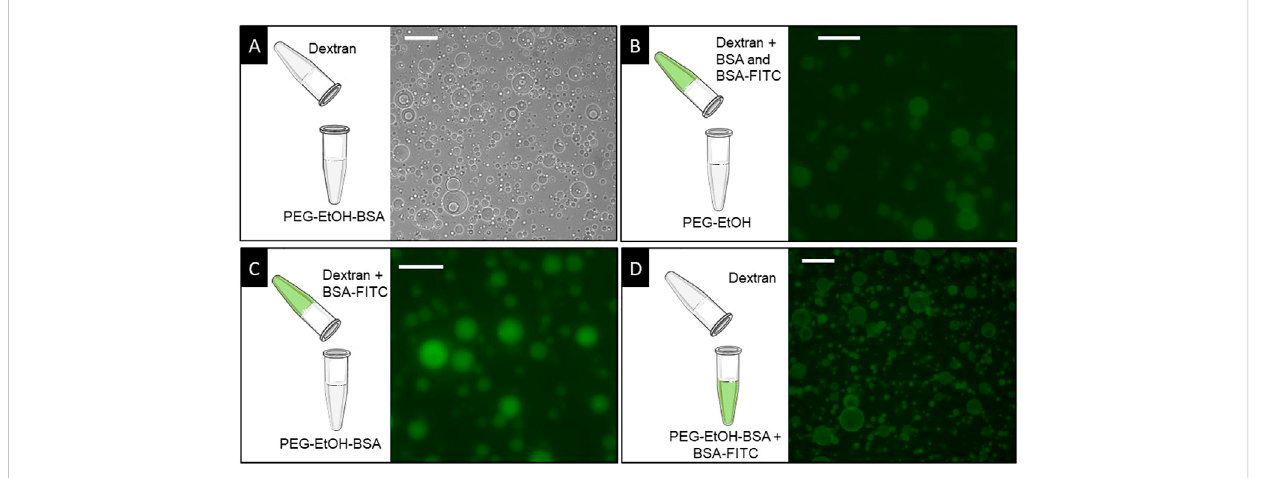
FIGURE 4 Schemes and microscopy images showing the formation of stable droplets using the second method (see main text). (A) Stable droplets observed usingbright fi eldmicroscopyafterpouringDex-richsolutionwithinadispersionofPEG-ethanol-BSA. (B – D) StabledropletsobservedusingBSA-FITC via